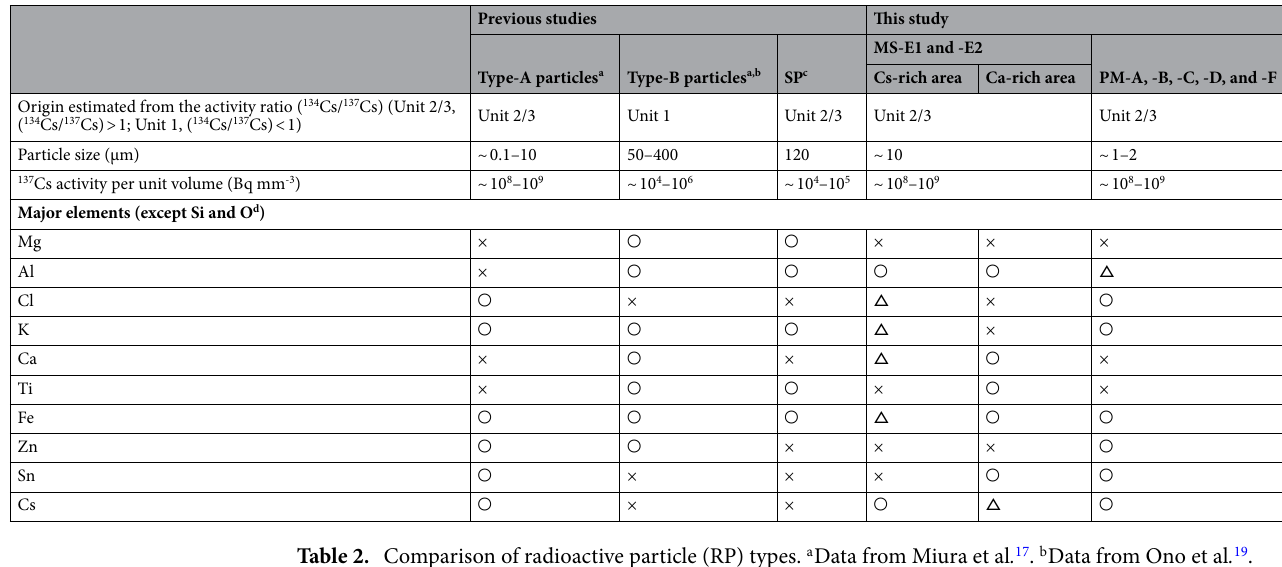
Table 2. Comparison of radioactive particle (RP) types. a Data from Miura et al . 17 . b Data from Ono et al . 19 . c CsMP reported by Zhang et al . 24 (particle name: SP). d ○ , detected; △ , detected in only some particles or only a slight amount detected; ×, not detected.